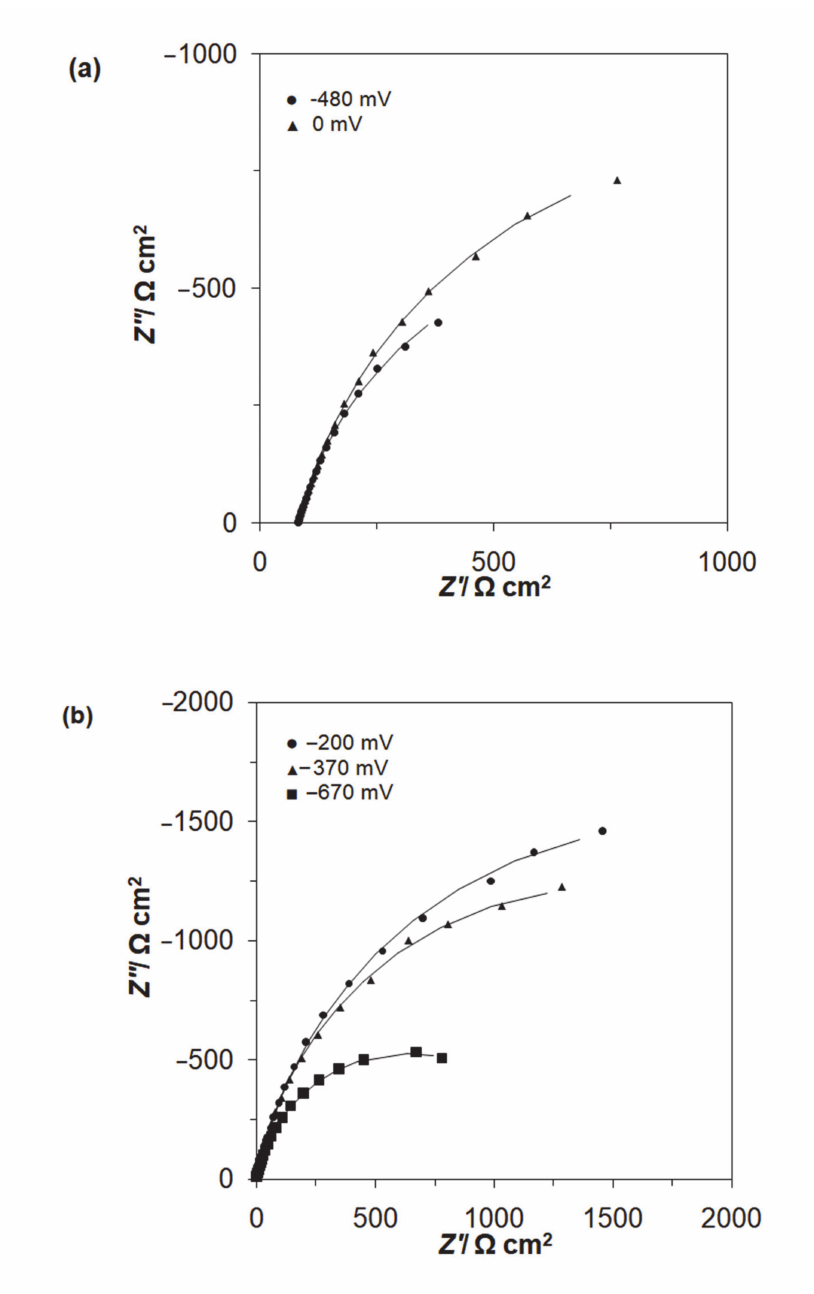
Figure 6. Complex plane Nyquist impedance plots for Al alloy electrode in contact with ( a ) 0.054 M Na 2 SO 4 -based Acid Mixture solution, ( b ) 0.054 M Na 2 SO 4 -based Disperse Red 167 solution, both dyes at the concentration of 50 mg dm − 3 , recorded for the stated potential values vs. SCE. The solid lines correspond to the representation of the data according to the equivalent circuit shown in Figure